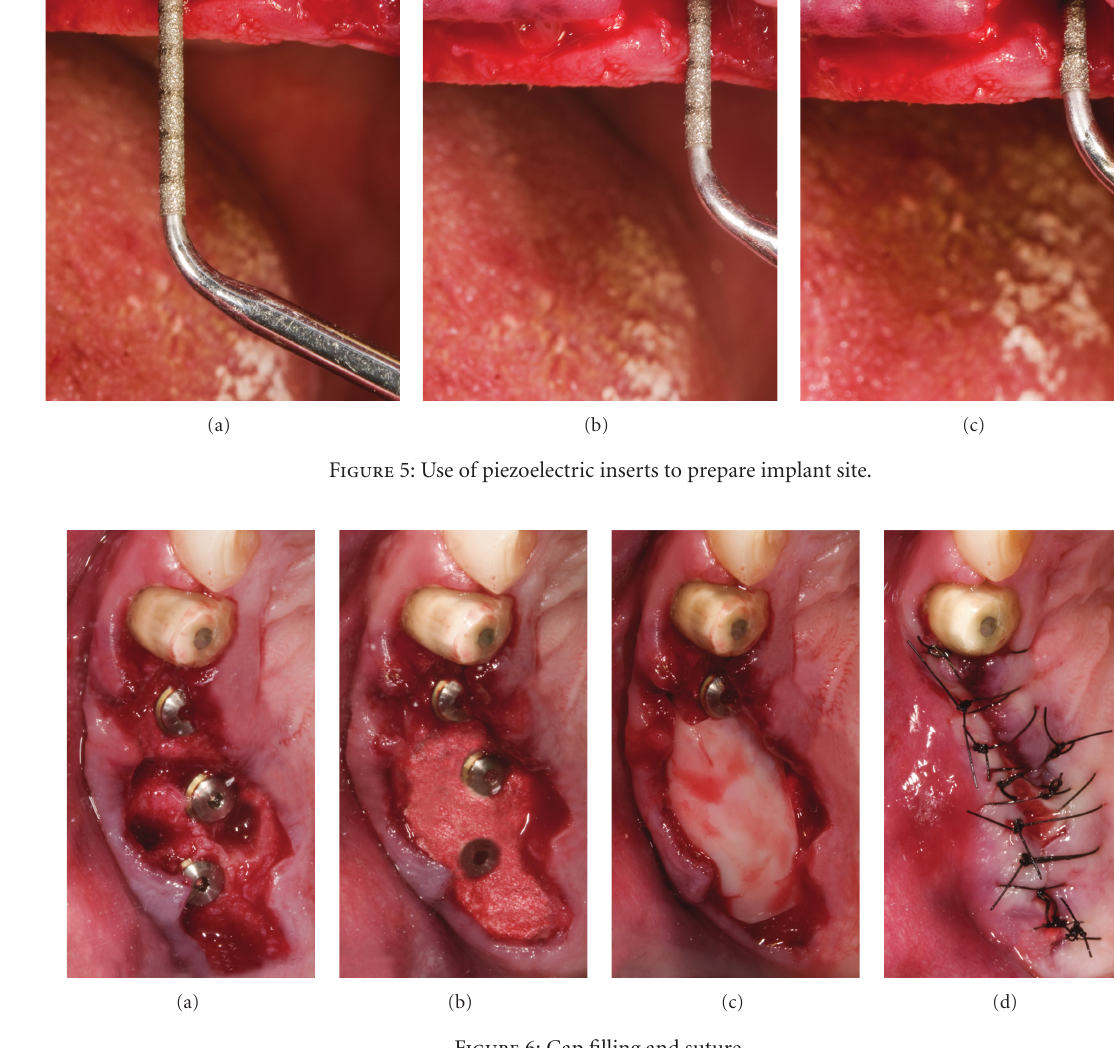
Figure 6: Gap filling and